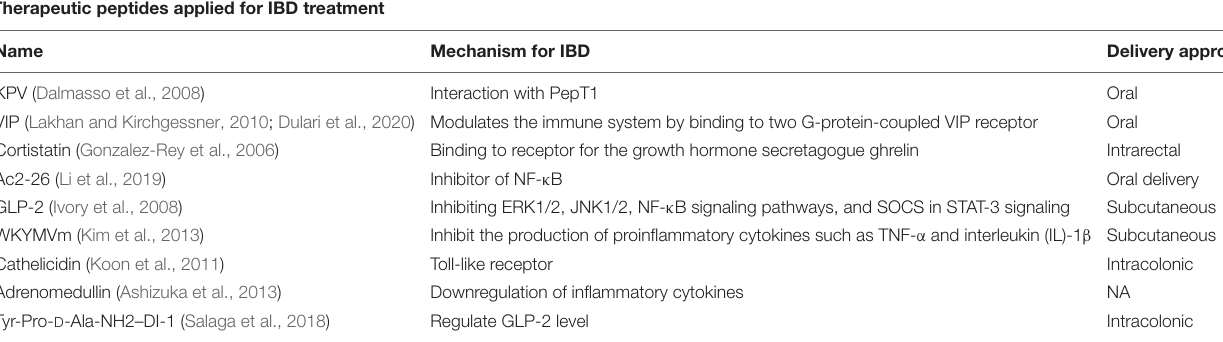
TABLE 2 | Therapeutic peptides applied in IBD treatment. Therapeutic peptides applied for IBD